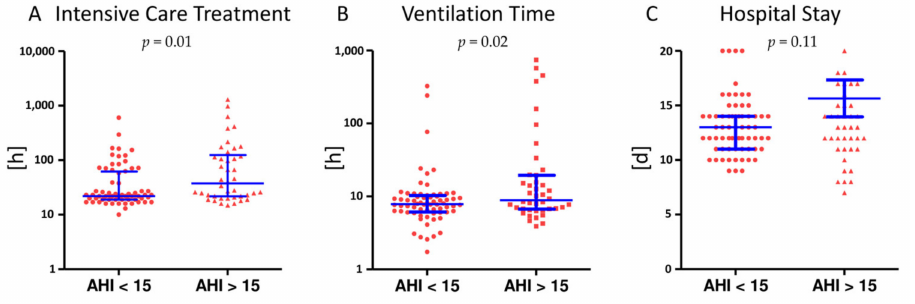
Figure 3. Impact of SDB on perioperative